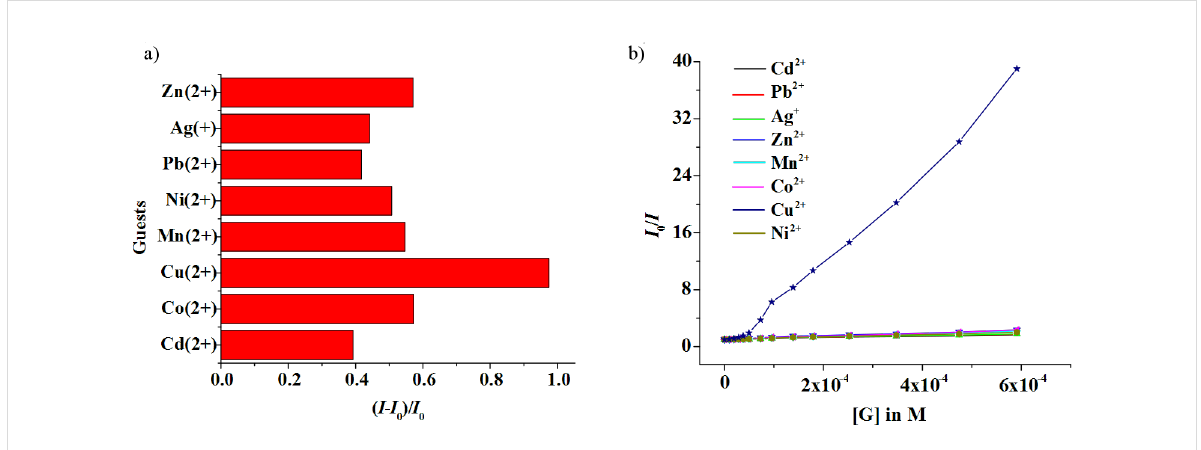
Figure 3: a) Fluorescence ratio ( I - I 0 / I 0 ) of receptor 1 ( c = 5.09 × 10 − 5 M) at 413 nm upon addition of 20 equiv of a particular guest in CH 3 CN containing 0.02% DMSO ( λ ex = 348 nm); b) Stern–Volmer plot of receptor 1 ( c = 5.09 × 10 − 5 M) at 413 nm upon addition of 20 equiv of a particular guest in CH 3 CN containing 0.02% DMSO ( λ ex = 348